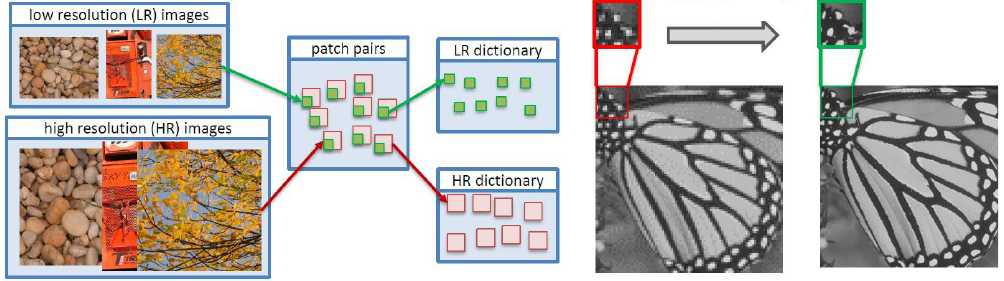
Figure 9. Example-based super-resolution using external learning [6].